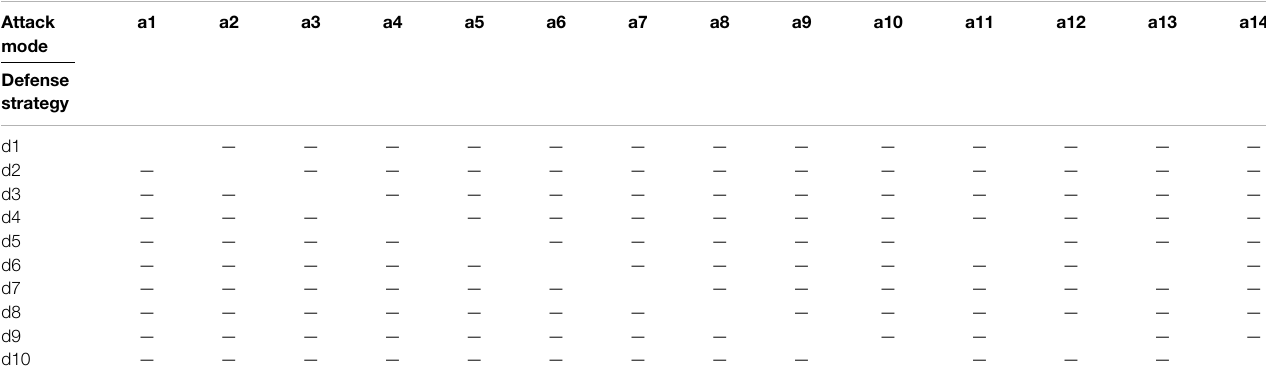
TABLE 6 | Nash equilibrium point under various attack modes.